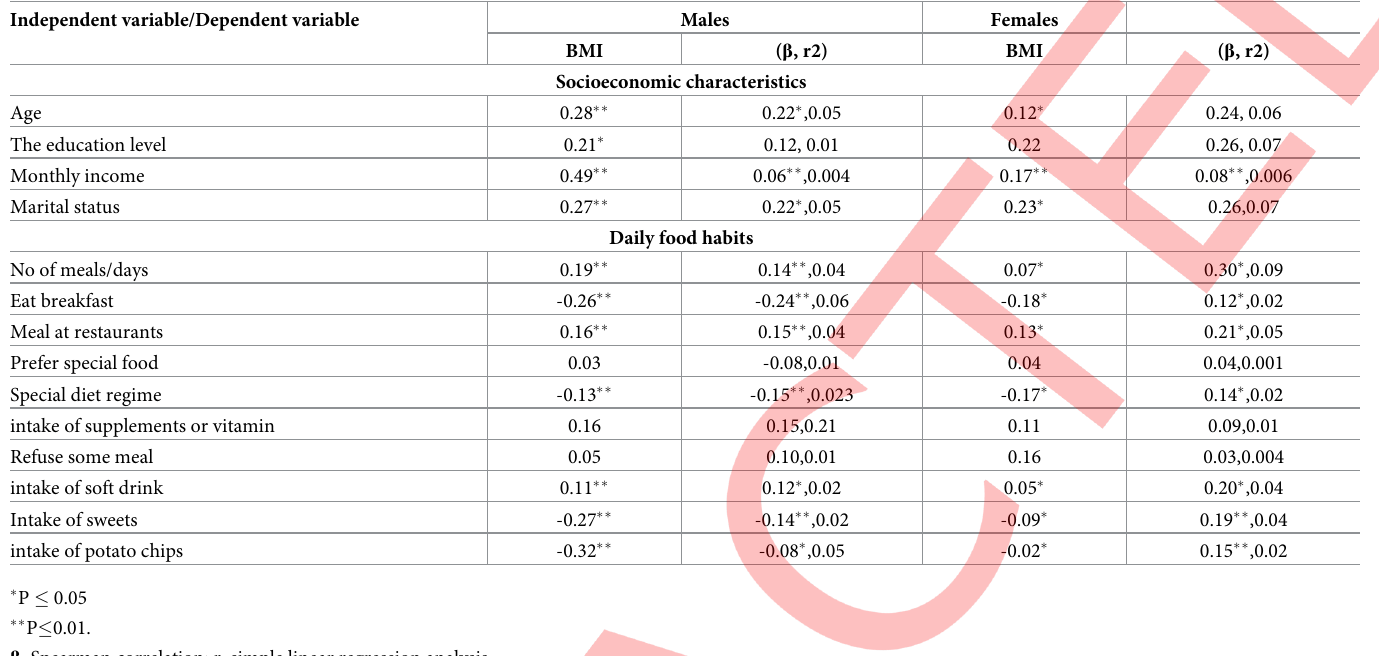
( β = 0.12, r 2 = 0.01). Additionally, monthly income was positively correlated with the BMI (P � 0.01) of both male and female students with a high effect on male ( β �� = 0.06, r 2 = 0.004) and female BMI ( β �� = 0.08, r 2 = 0.006). However, marital status was highly significant (P � 0.01) and positively correlated with the males’ BMI ( β � = 0.22, r 2 = 0.05), while females had low significance (P � 0.05) as indicated by regression analysis ( β = 0.26, r 2 = 0.07). Spear- man correlation coefficients and simple regression analysis were calculated as dependent vari- ables between the respondents’ BMI and daily food habits as independent variables (Table 5).